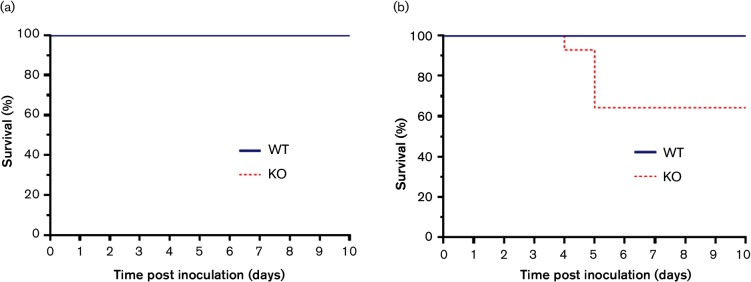
Survival curves of chickens inoculated with WT or KO UDL01 influenza virus. Survival curves of chickens inoculated into the nares with 100 µl of PBS containing (a) 5×103 p.f.u. (low dose) or (b) 1×105 p.f.u. (high dose) of either WT (blue line) or KO (red dashed line) UDL01 influenza virus.